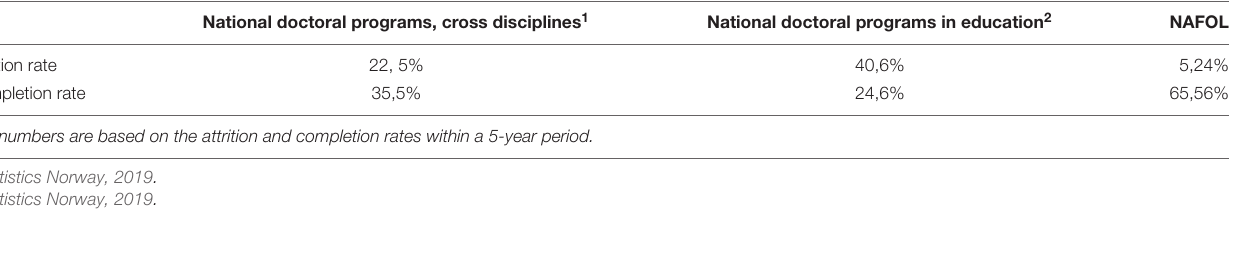
TABLE 1 | Attrition and completion rates of Ph.D.